Question: What form of chart is displayed?
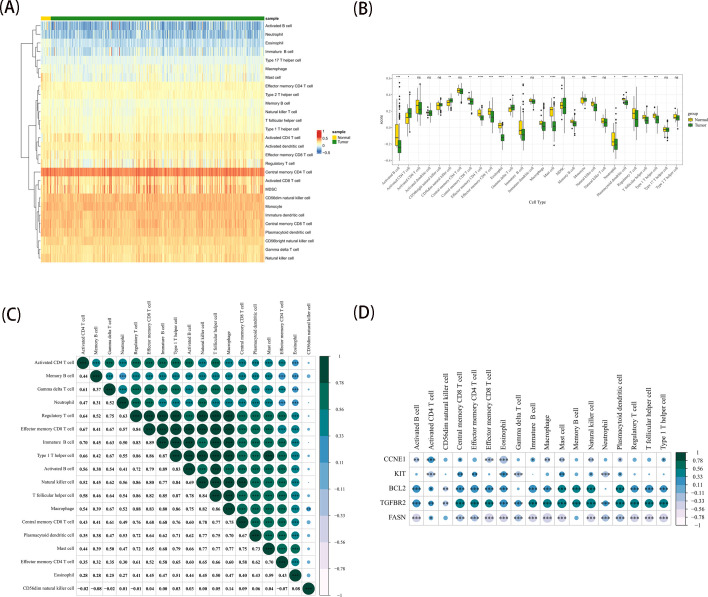
Answer: heatmap